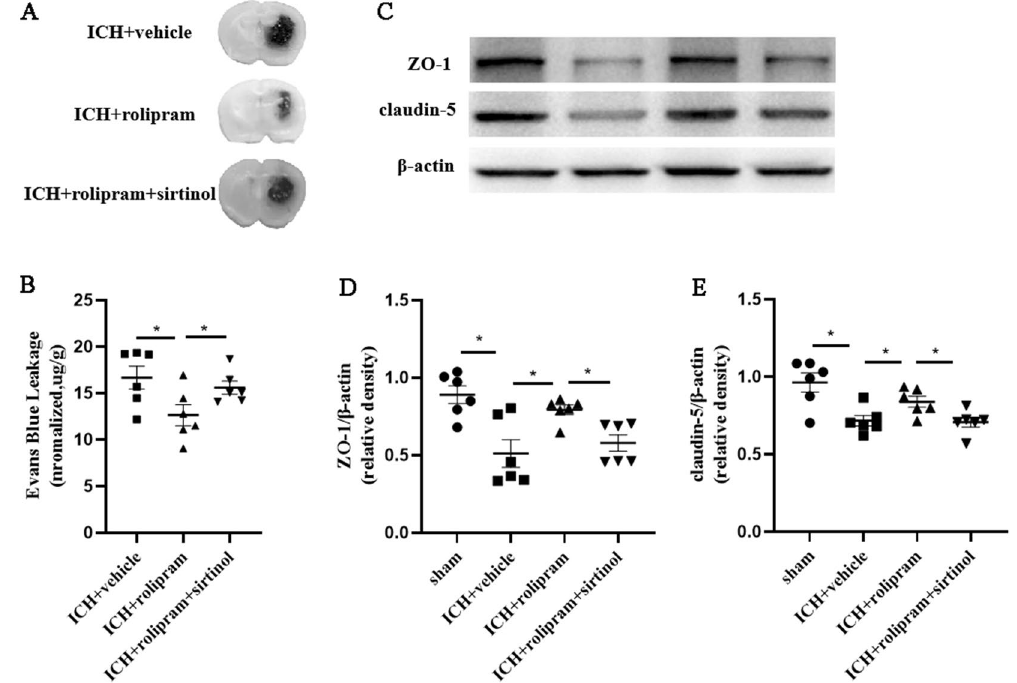
Figure 3. Rolipram alleviated BBB damage and EB leakage and increased the expression of tight junction proteins. ( A , B ) BBB permeability and EB leakage. ( C – E ) Western blot analysis of claudin-5 and ZO-1 in the different groups. The Mann–Whitney U test was used to compare differences between groups in biochemical and histological test. The data are presented as the means ± SEM. * p < 0.05 (Supplementary Information 1).